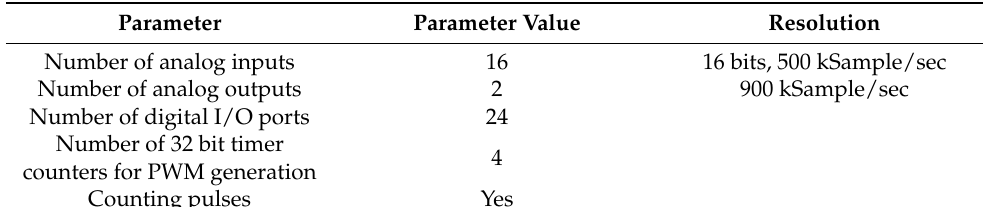
Table 2. Technical characteristics of ADC for collecting diagnostic information from sensors.